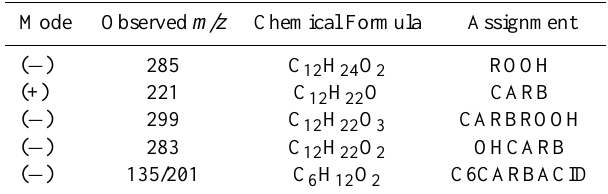
Table 4. Selected ions monitored by the CIMS for hexylcyclohex- ane and